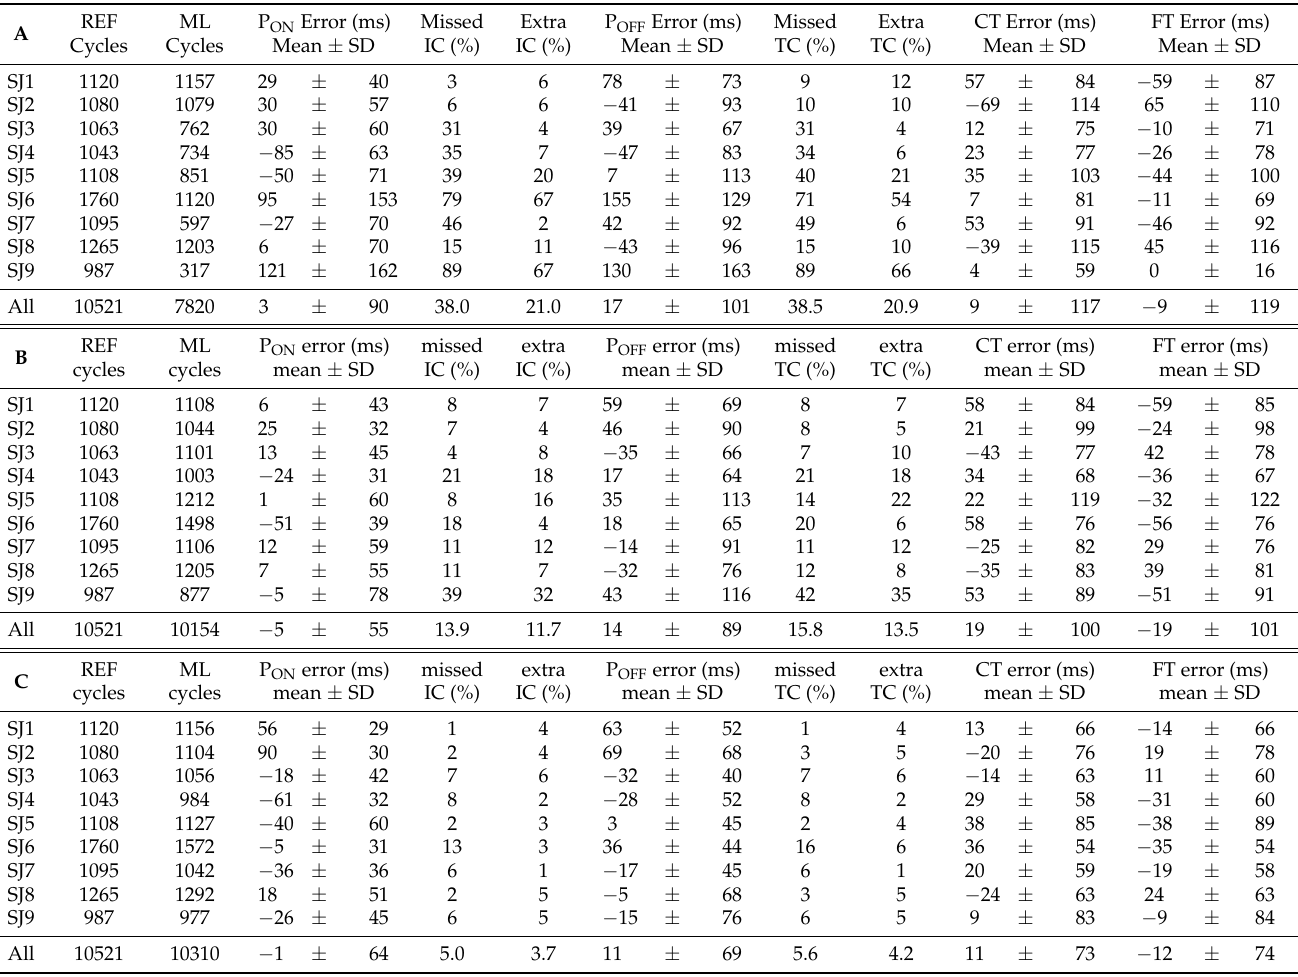
Table 1. Results for the parameters obtained for the poles, using the sensors placed on the sacrum ( A ), the sternum ( B ) and the upper back ( C ). Each row represents the training of the network on eight participants, which was tested on the remaining